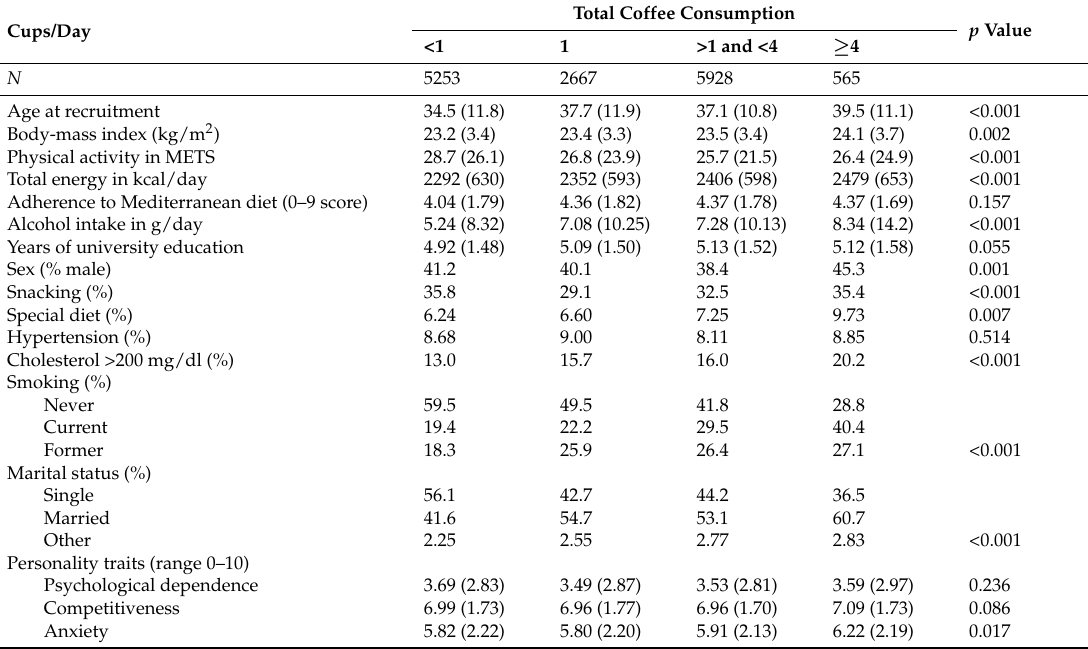
Table 1. Baseline characteristics of participants according to total coffee